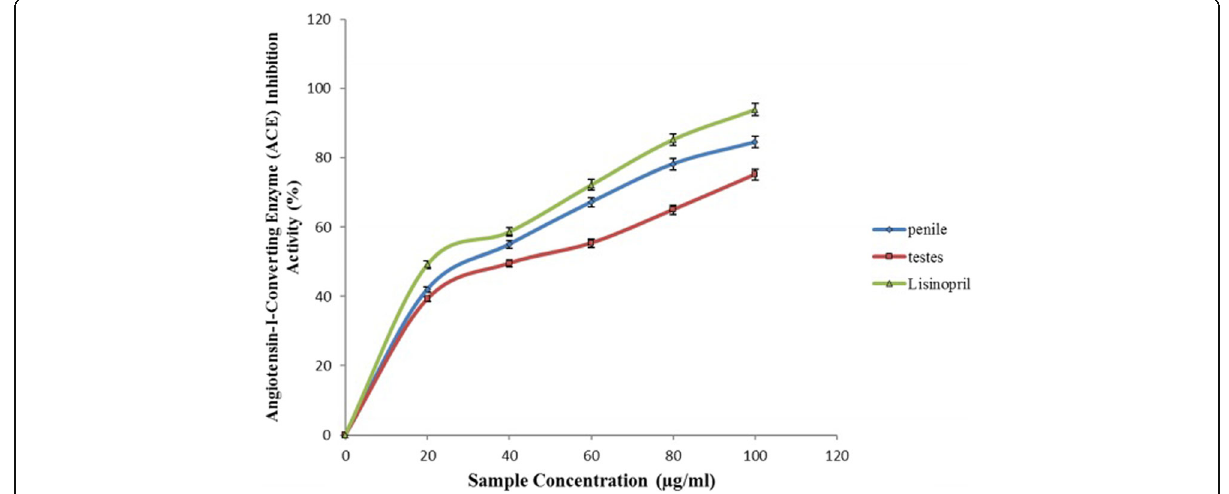
Fig. 4 Inhibition of Angiotensin-I-converting enzyme activity in rats ’ genitals by aqueous extract from Ocimum gratissimum